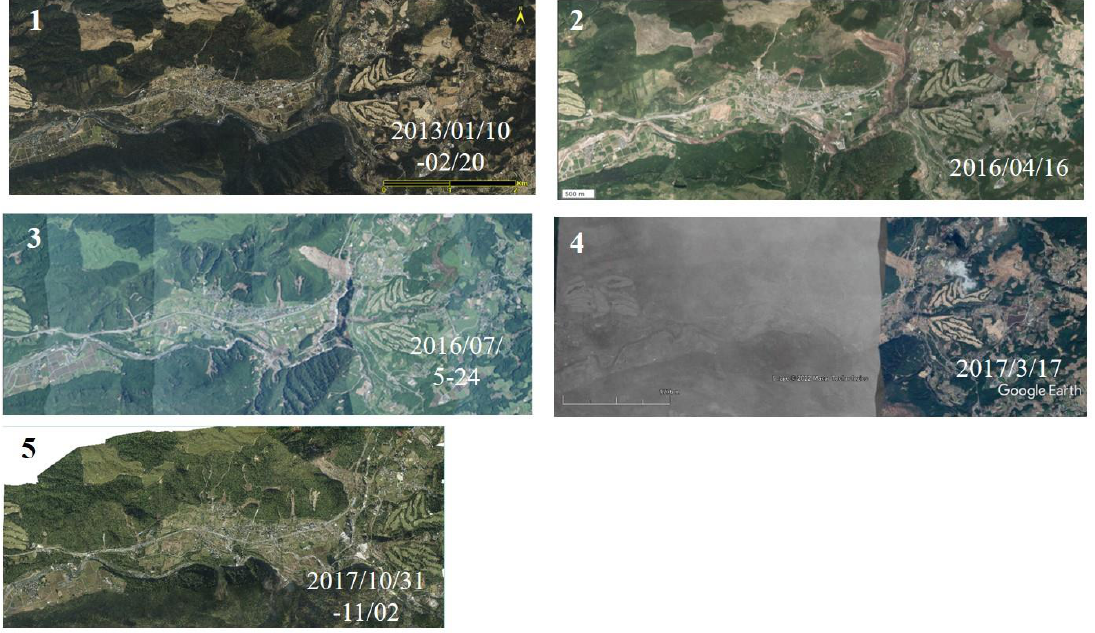
Figure 4. Optical images acquired at similar times from the five LiDAR datasets for the study area of Mimami-Aso